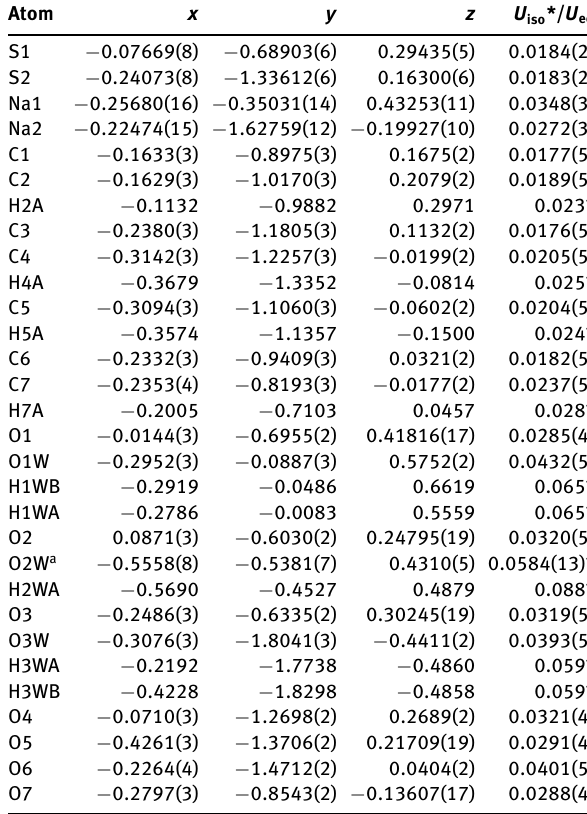
Table 2: Fractional atomic coordinates and isotropic or